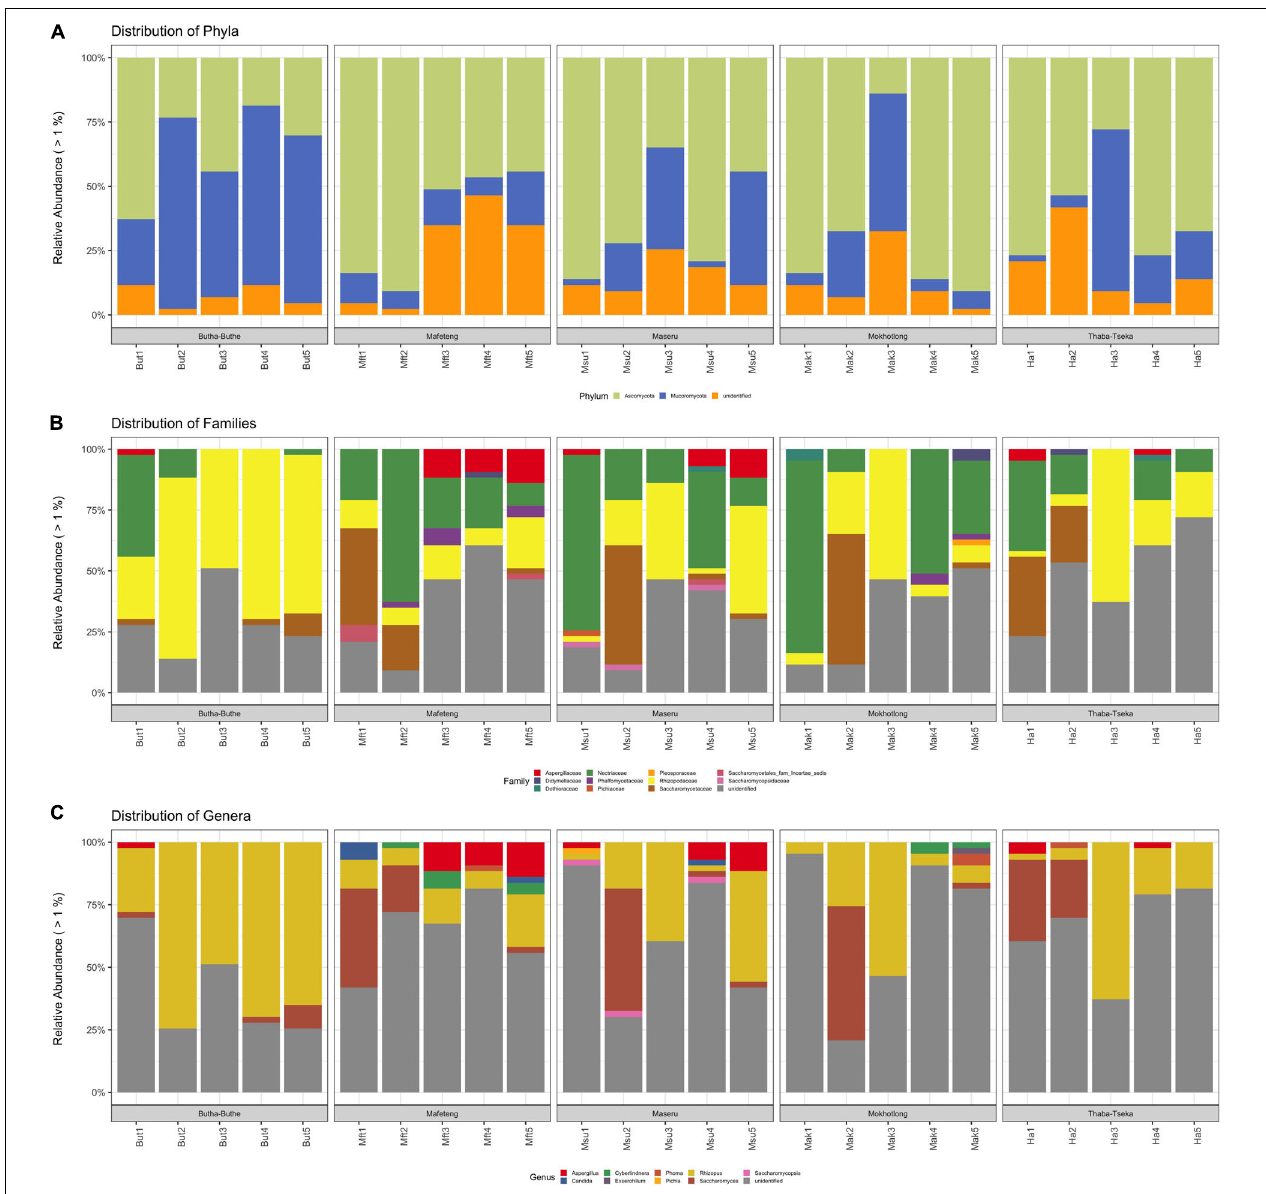
FIGURE 4 | Distribution of fungal taxa in Sesotho. (A) Phylum, (B) Family, and (C) Genus level.